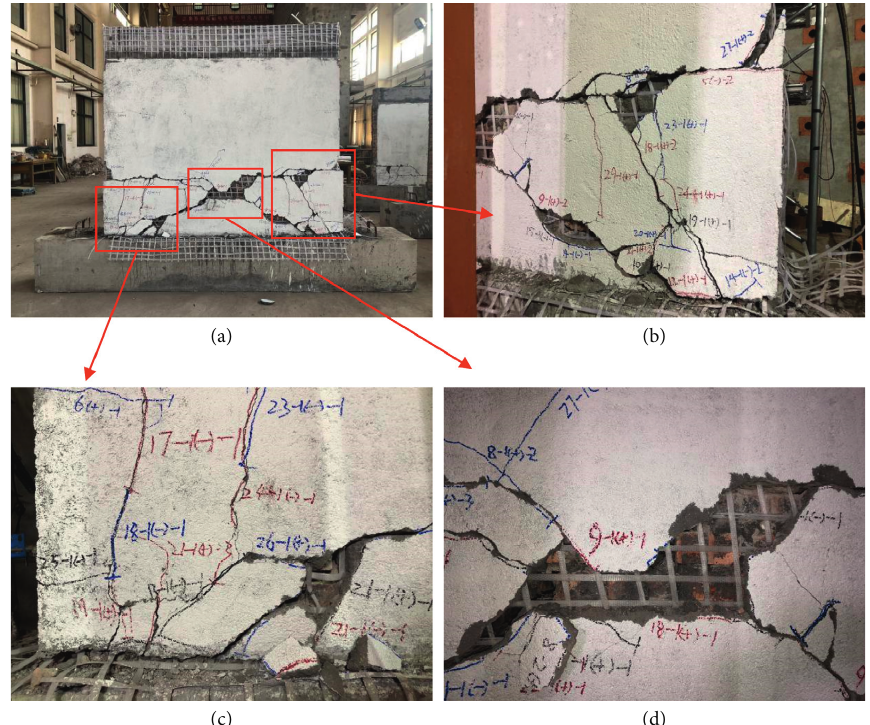
Figure 8: Damage mode of unstrengthened specimen JW-1. (a) Overall damage, (b) damage in the bottom left corner, (c) damage in the bottom right corner, and (d) The PP-band mesh is still working.